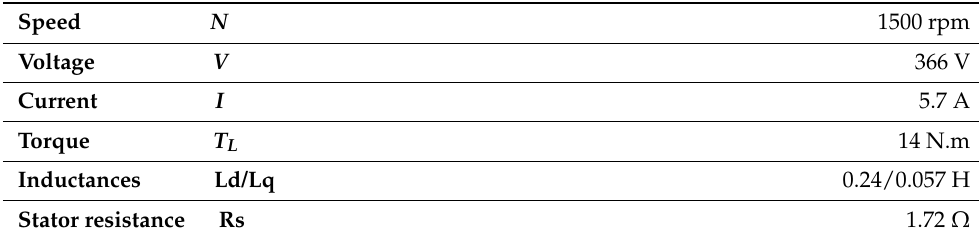
Table 1. Parameters Of The Used 2.2 Kw